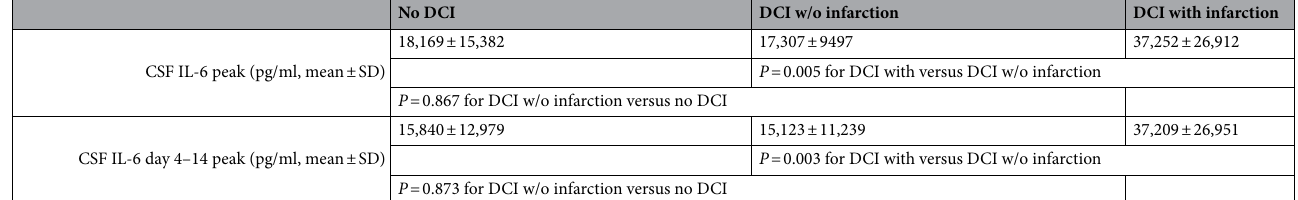
No DCI DCI w/o infarction DCI with infarction CSF IL-6 peak (pg/ml, mean ± SD) P = 0.005 for DCI with versus DCI w/o infarction P = 0.867 for DCI w/o infarction versus no DCI P = 0.003 for DCI with versus DCI w/o infarction P = 0.873 for DCI w/o infarction versus no Table 4. Individual interleukin-6 peak levels in patients with and without DCI and/or infarction. CSF cerebrospinal fluid, DCI delayed cerebral ischemia, SD standard deviation, w/o without.